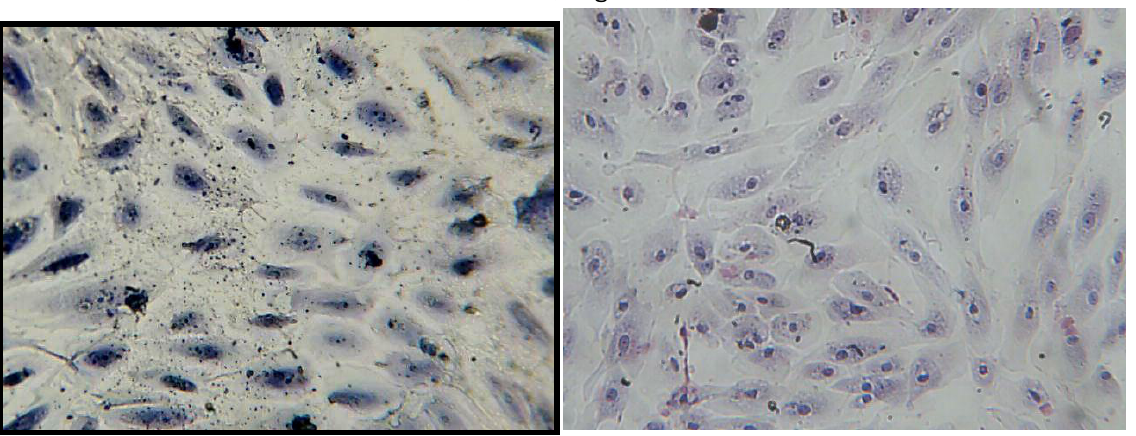
Figure (11): heamadsorption test showing adsorption of guinea pig RBCs around the infected SEBK cells 100 x. Figure (12): Non infected SEBK cell culture 100